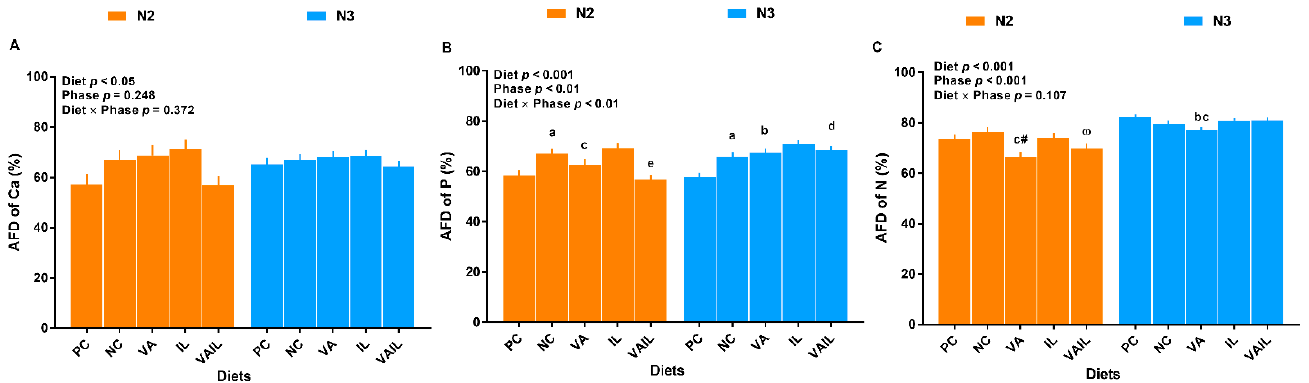
Figure 2. Apparent fecal digestibility (AFD) of ( A ) calcium (Ca), ( B ) phosphorus (P) and ( C ) nitrogen (N) in nursery pigs fed with very low protein diets supplemented with isoleucine (Ile) at NRC and valine (Val) above NRC levels, or a combination of the two. PC: positive control, standard protein diet; NC: negative control, very low protein diet containing first four limiting amino acids (i.e., lysine, methionine, threonine, and tryptophan) at NRC (2012) levels; VAIL: NC containing Val above NRC and Ile at NRC levels. a p ≤ 0.05 NC vs. PC, b p ≤ 0.05 VA vs. PC, c p ≤ 0.05 VA vs. NC, d p ≤ 0.05 VAIL vs. PC, e p ≤ 0.05 VAIL vs. NC, # p ≤ 0.1 VA vs. PC, ω p ≤ 0.1 VAIL vs. NC. The values are means ± standard error of the mean. n = 8.